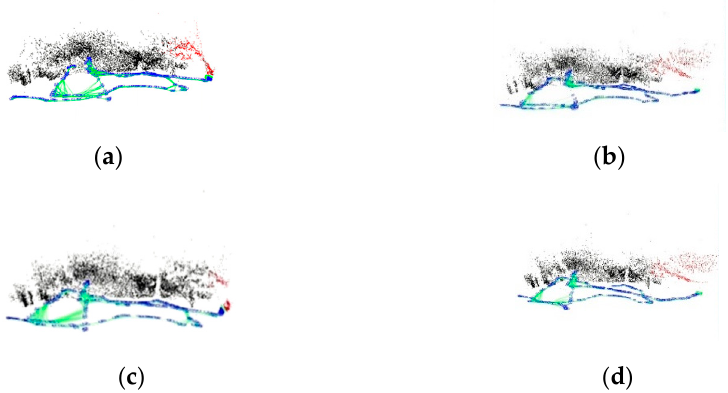
Figure 10. SLAM results for the Test 1 dataset. ( a ) Original; ( b ) CLAHE; ( c ) MF; ( d ) DCP.